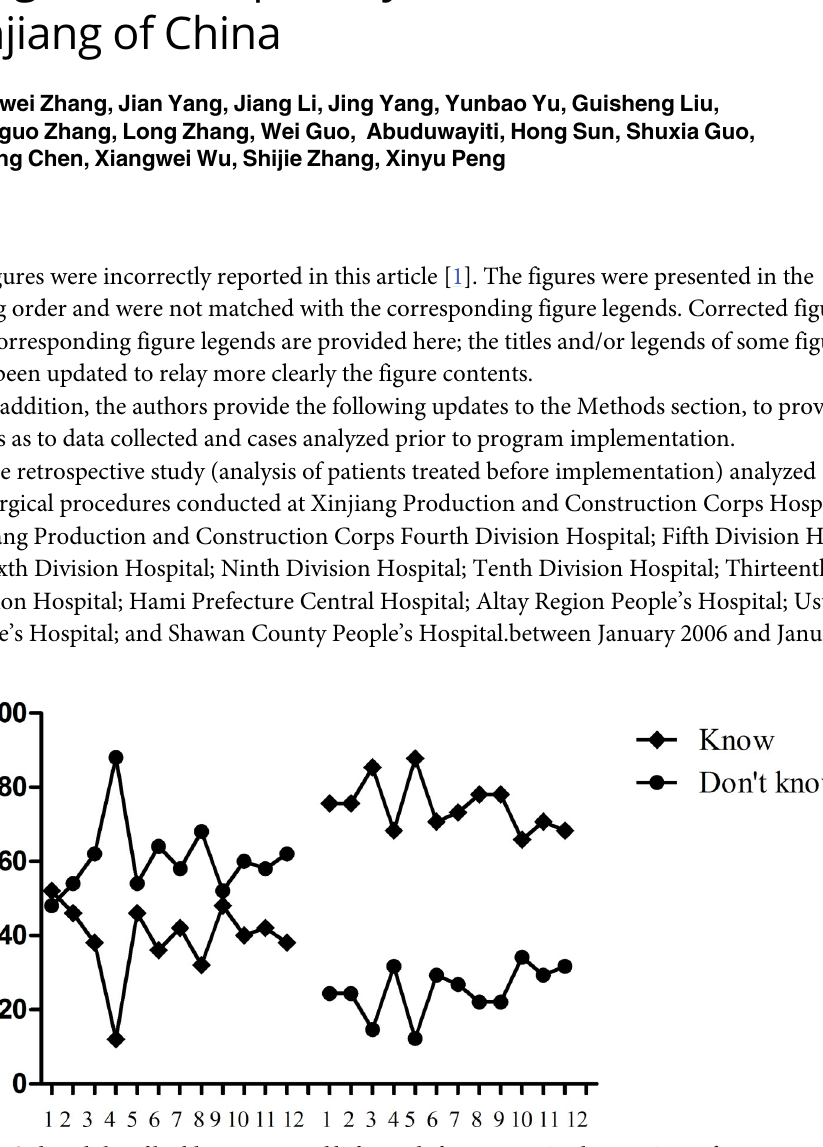
Fig 1. HCE knowledge of health care personnel before and after program implementation. Before program implementation, HCE knowledge of most of health care personnel was poor. After program implementation, knowledge increased. (p < 0.05 by the chi-square test.) 1–12 denote the following questions: 1. Characteristics of echinococcosis; 2. The definitive host and intermediate host of cystic echinococcosis; 3. Most affected organs; 4. Drug of first choice; 5. Best radical surgery; 6. Intraoperative scolecidal agents and acting time; 7. Precautions in radical surgical approaches; 8. Sub-adventitial cystectomy in the surgical treatment of HCE; 9. Contrast enhanced